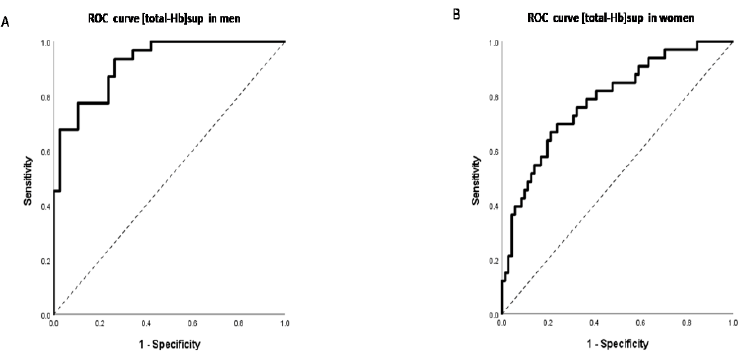
Figure 9. Receiver-operating characteristic (ROC) curves for total hemoglobin in the supraclavicular region ([total-Hb]sup) in men ( A ) and women ( B ). The area under the ROC curve determined by [total-Hb]sup closest to (0, 1) for the predicted formula determined by the amino acid (AA) and anthropometric parameters was selected.